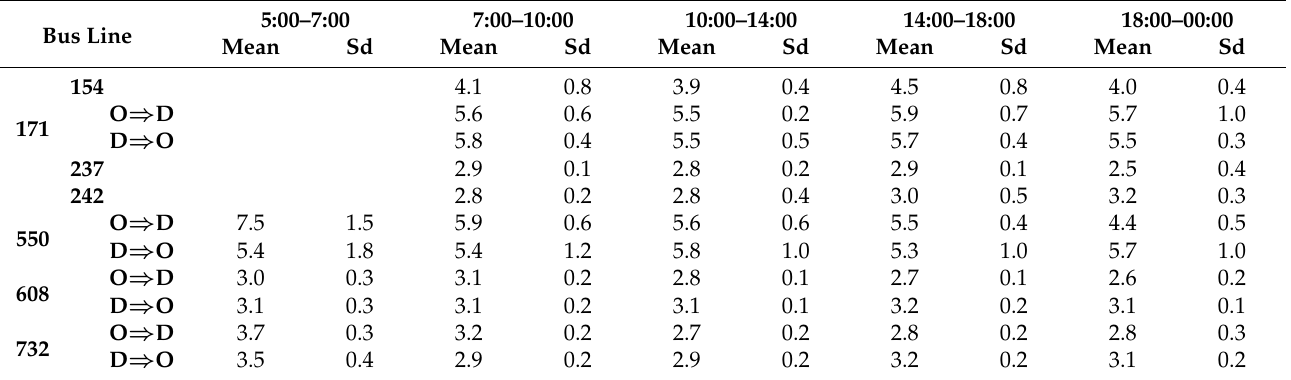
Table 3. Passenger travel distance (km) per bus line and time